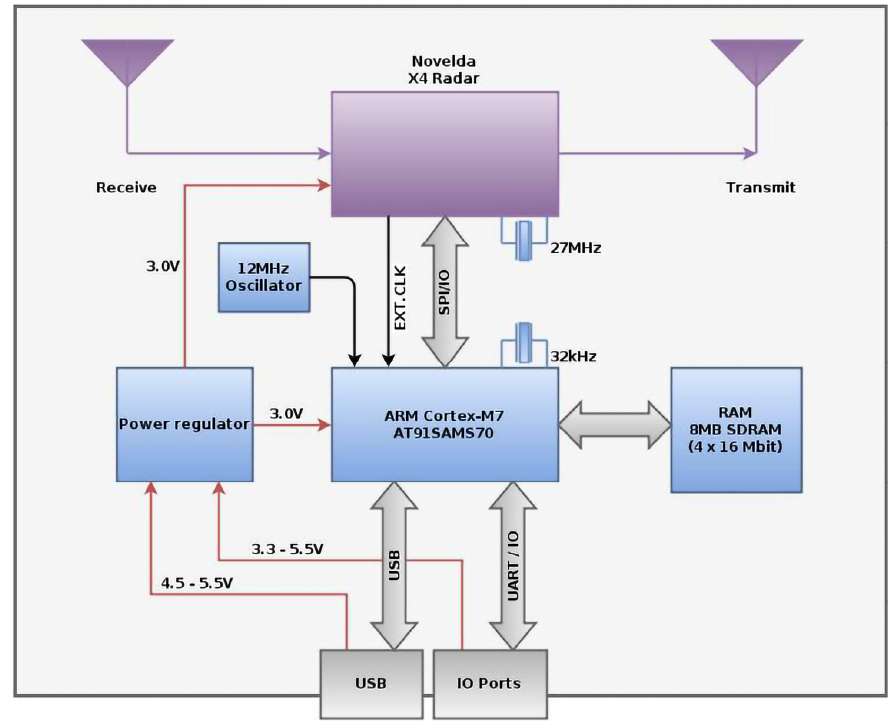
Figure 3. Block diagram of UWB X4M200 RADAR sensor. Retrieved 30 June 2022, from: https: